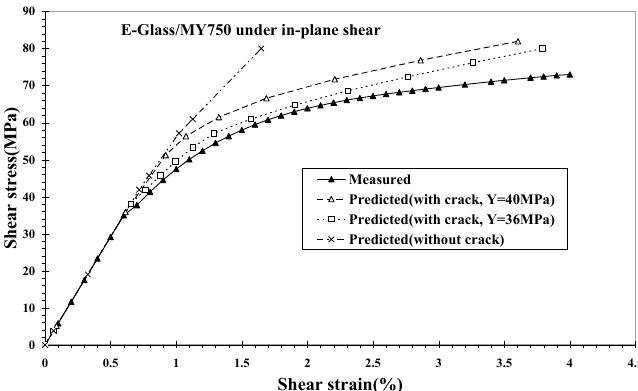
Figure 8. In-plane shear stress–strain curve of E-glass/MY750 up to failure.